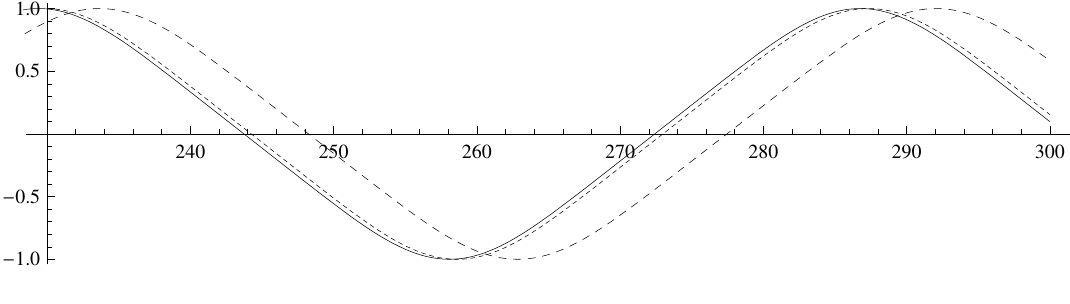
Figure 3 . Solution x ( t ) of the truncated equation (3.5) for x (0) = 1, _ x (0) = 0, m = (cid:28) = 1, (cid:21) = 1 = 10. The sparsely dashed line is n = 1. The densely dashed line is n = 2, while the continuous line is n = 3. The solution remains stable from n = 3 to n =